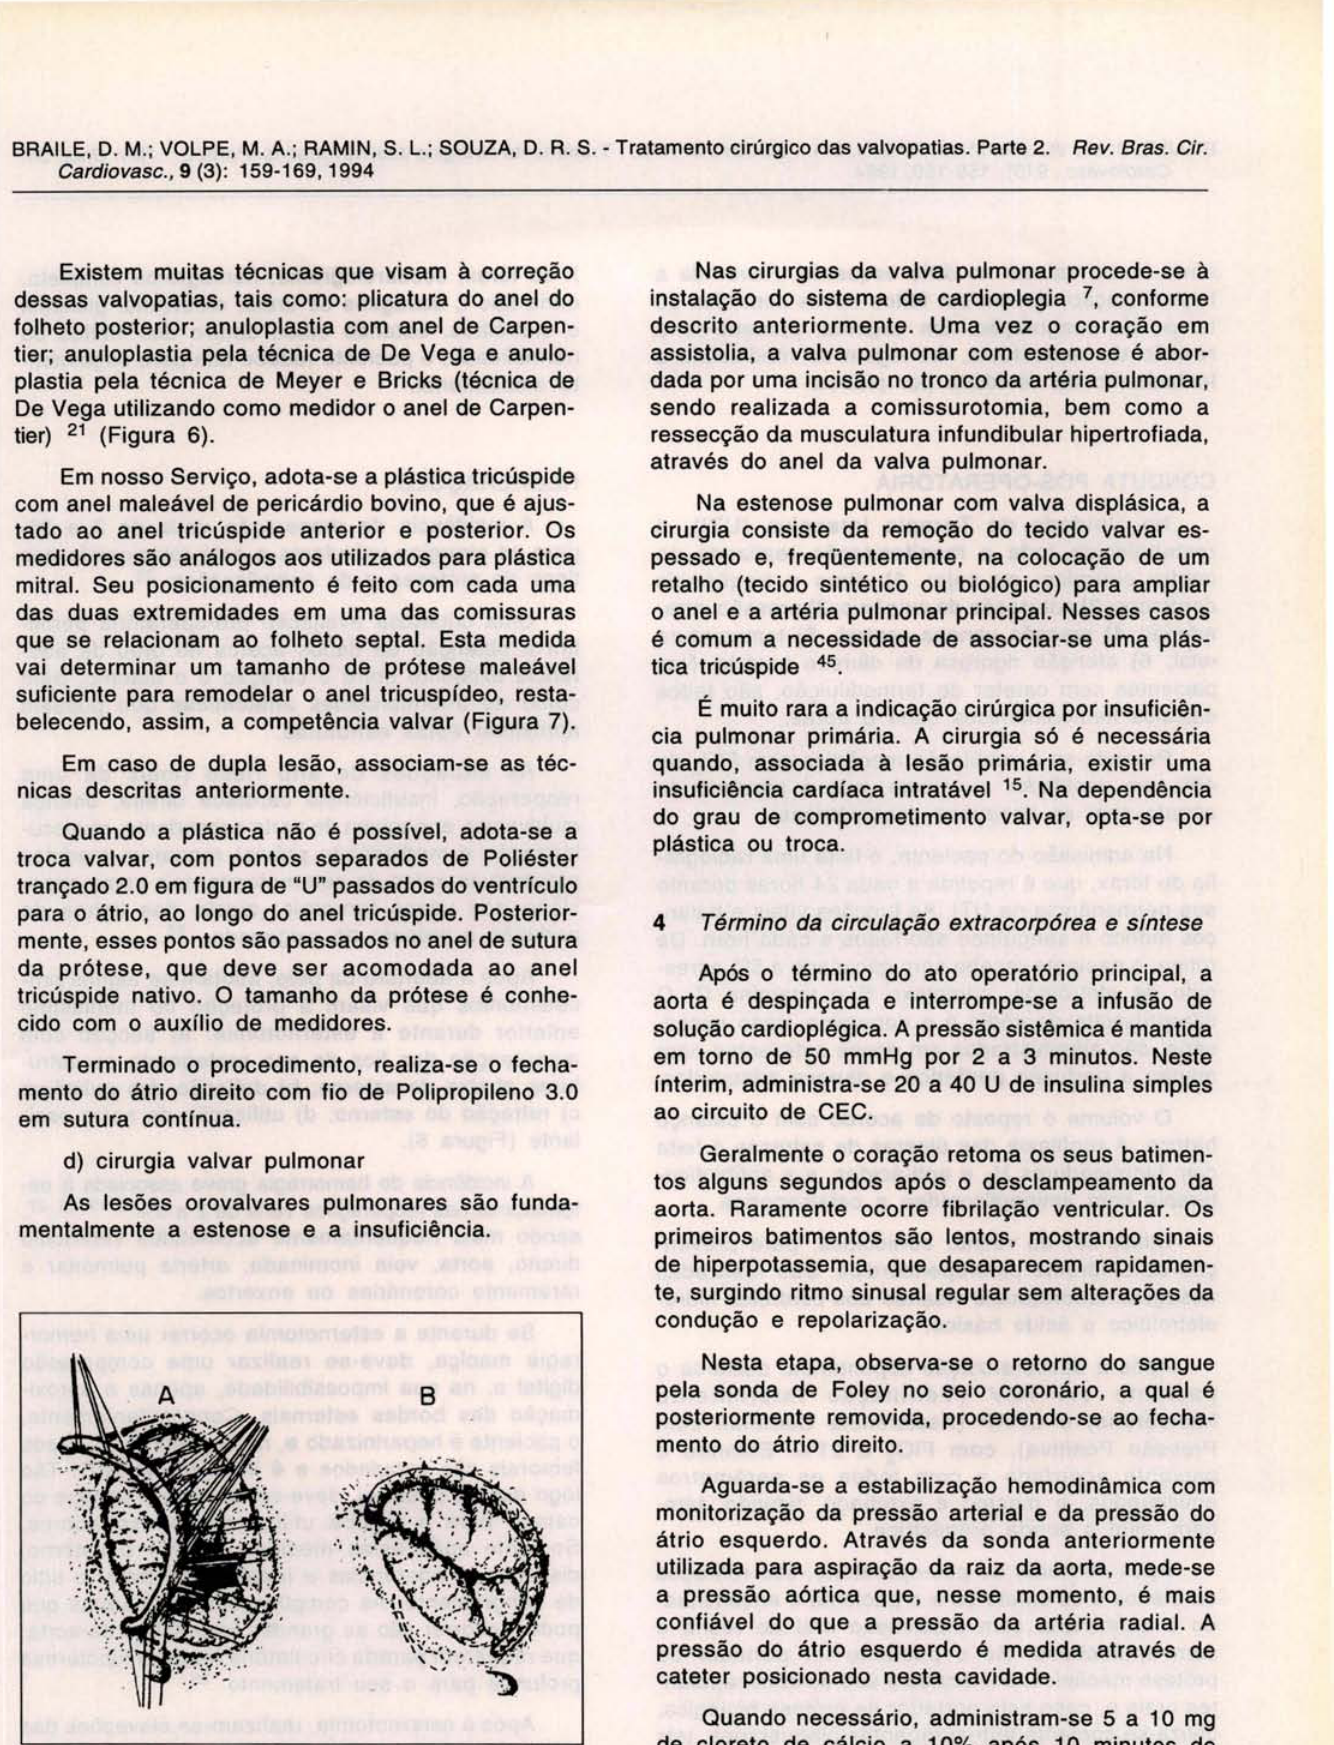
Fig. 7 - Plástica tricúspide com anel maleável. (A) Pontos no anel tricúspide anterior e posterior e no anel. (B) Ajuste do anel maleável restabelecendo a competência valvar. Adaptado deKHONSARI, 1990 2